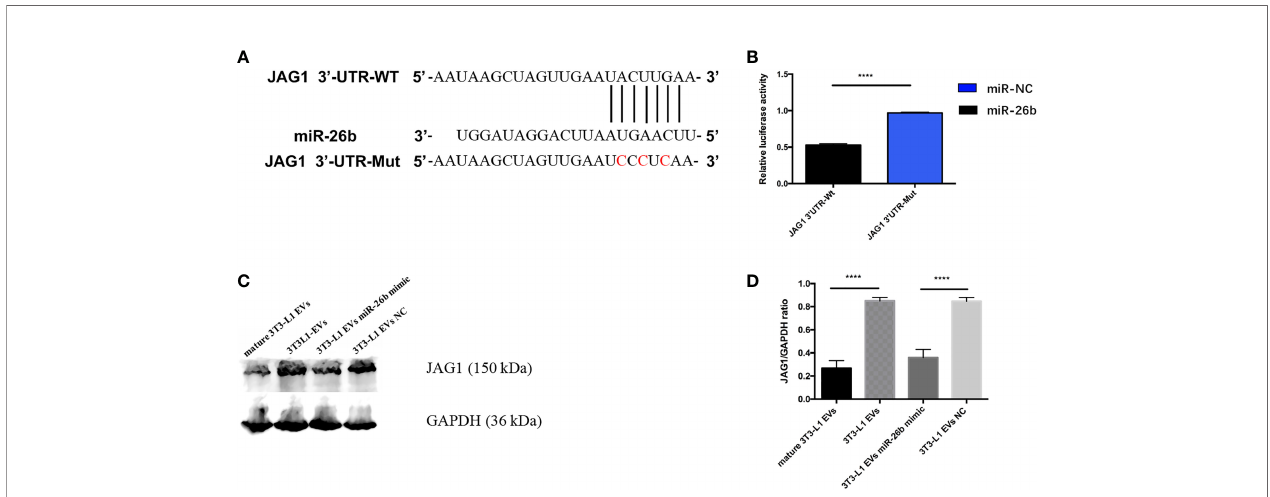
FIGURE 7 | MiR-26b promote CC apoptosis by regulating JAG1. (A) Construction of the JAG1-3 ′ -UTR WT and JAG1-3 ′ -UTR Mut vectors and the active sequence of miR-26b. (B) Luciferase reporter assay was performed to detect the relative luciferase activities of WT and mutant JAG1 reporters. Upregulated miR-26b repressed the fl uorescence intensity of JAG1-Wt-3 ′ UTR. (C) Detecting JAG1 protein expression level after treatment with diverse extracellular vesicles by Western blot assay; treatment with both mature adipocytes- and pre-adipocytes-derived EVs miR-26b mimics signi fi cantly decreased the expression of JAG1 when compared with pre-adipocytes- derived EVs. (D) Quanti fi cation of the JAG1 expression when treated with diverse extracellular vesicles; ****p < 0.0001.